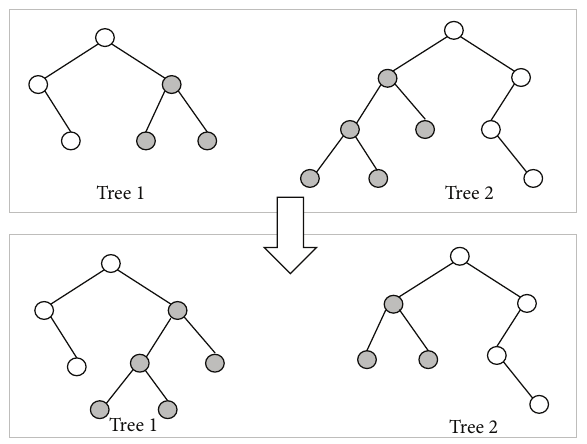
Figure 8: Apply swap subtree crossover operator to generate the offspring from the given parents.